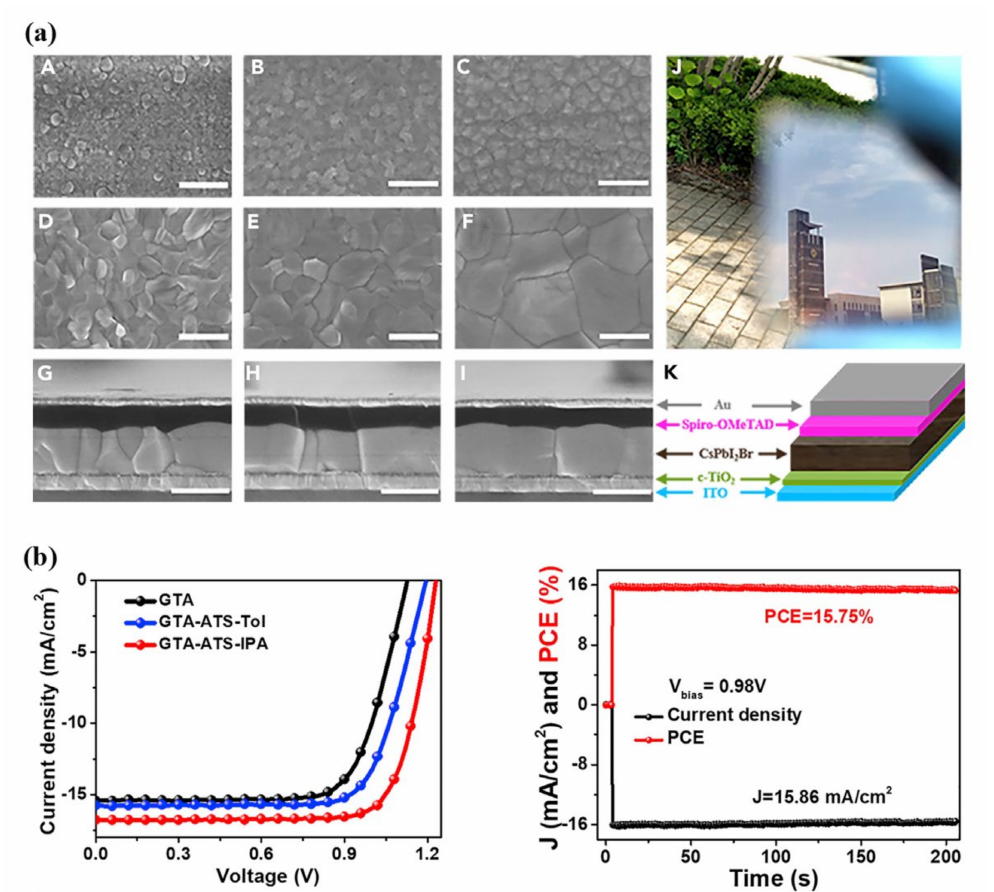
Figure 7. ( a ) The SEM images of the GTA, GTA-ATS-Tol, and GTA-ATS-IPA CsPbI 2 Br films: after pre-annealing process, 50 ◦ C/1 min, 100 ◦ C/1 min, and 160 ◦ C/10 min; cross-section SEM images of the photograph of the mirror-like GTA-ATS-IPA film; schematic view of PSCs; ( b ) J-V curves of the three PSCs. Reprinted with permission from Ref. [67]. 2015 Royal Society of